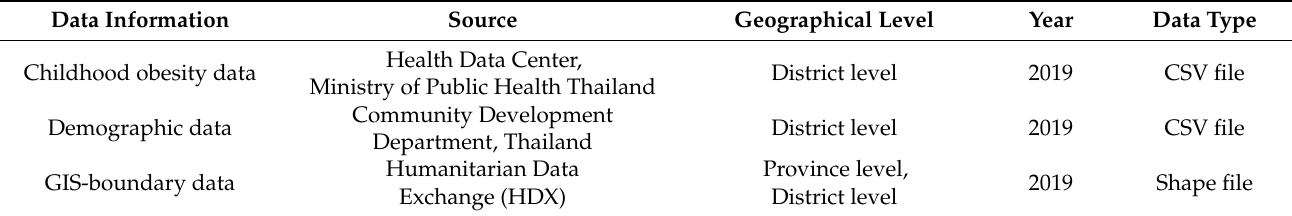
Table 1. Data collected and used in this